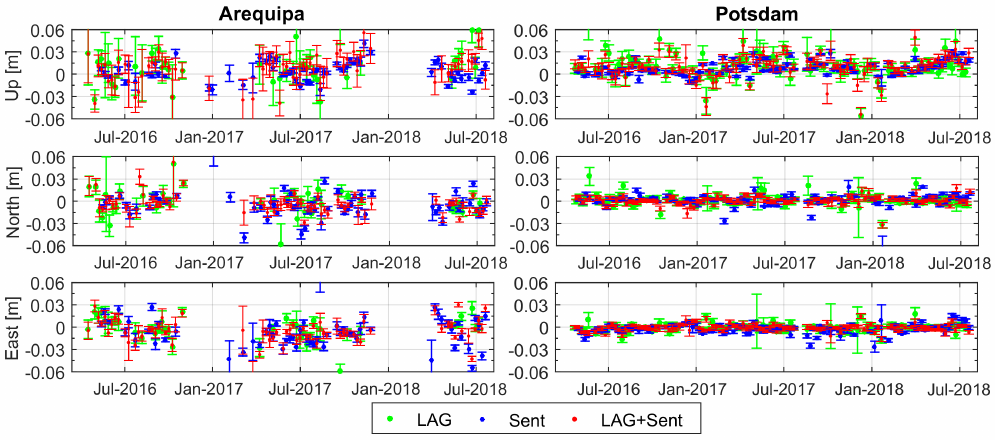
Figure 14. Time series (error bars) for Arequipa ( left ) and Potsdam ( right ) site coordinates w.r.t SLRF2014 for LAG (green), Sent (blue), LAG+Sent (red)